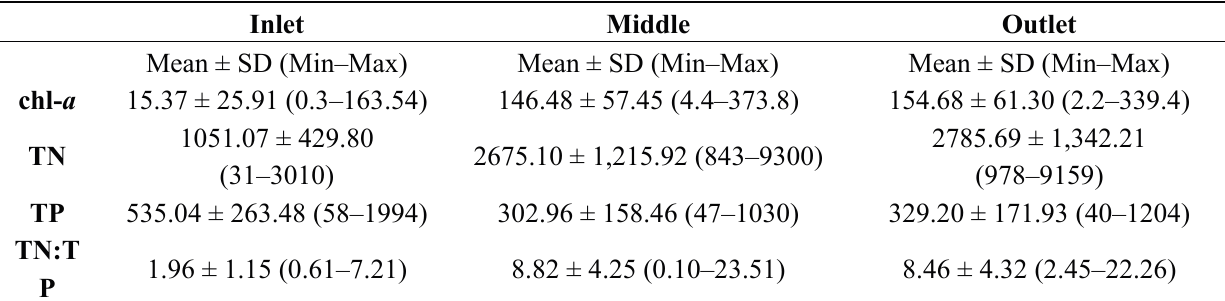
Table 3. Summary statistics for chl- a ( μ g/L), total nitrogen (TN) ( μ g/L), total phosphorus (TP) ( μ g/L) and the ratio TN:TP for the monthly water samples analysis of Lake Thonotosassa from 2000 to